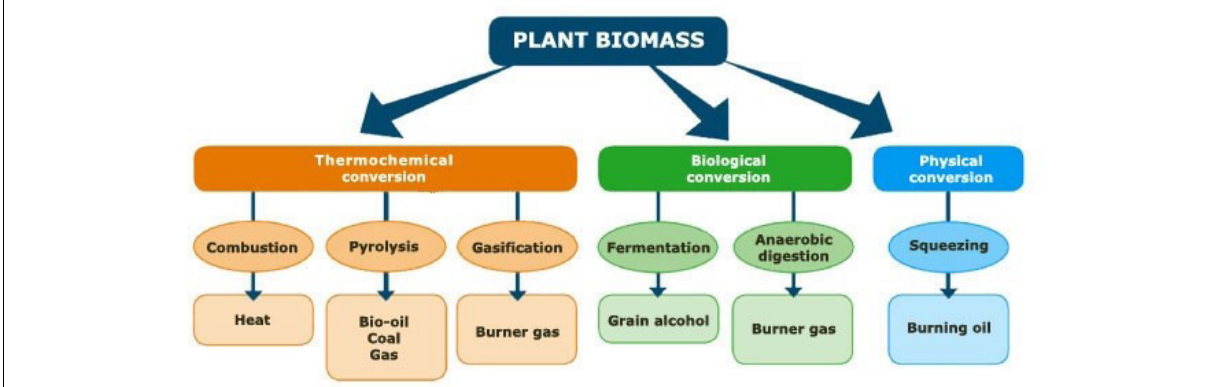
Figure 4: Biomass conversion methods for energy materials.